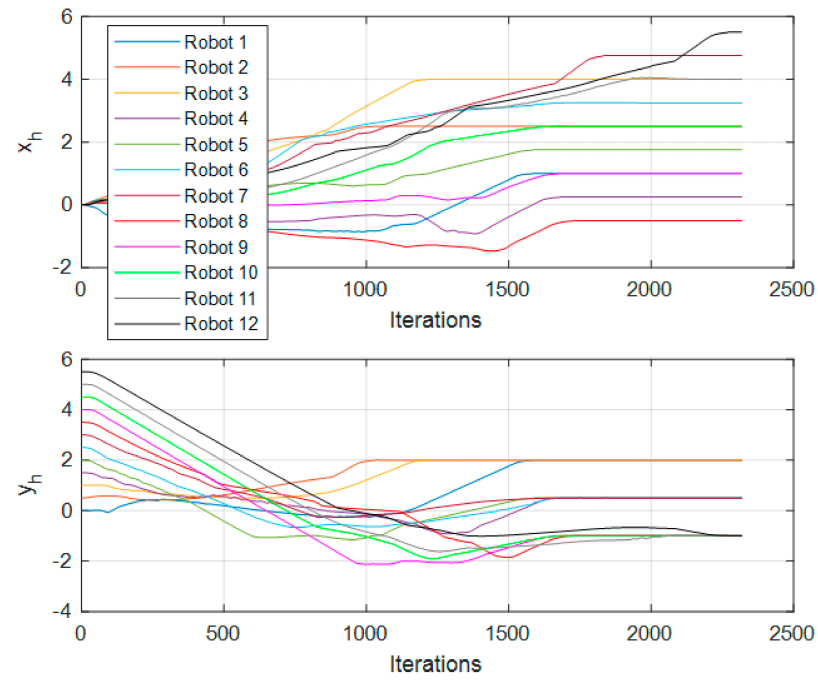
Figure 14. Trajectories along iterations in the 12-robot simulation.